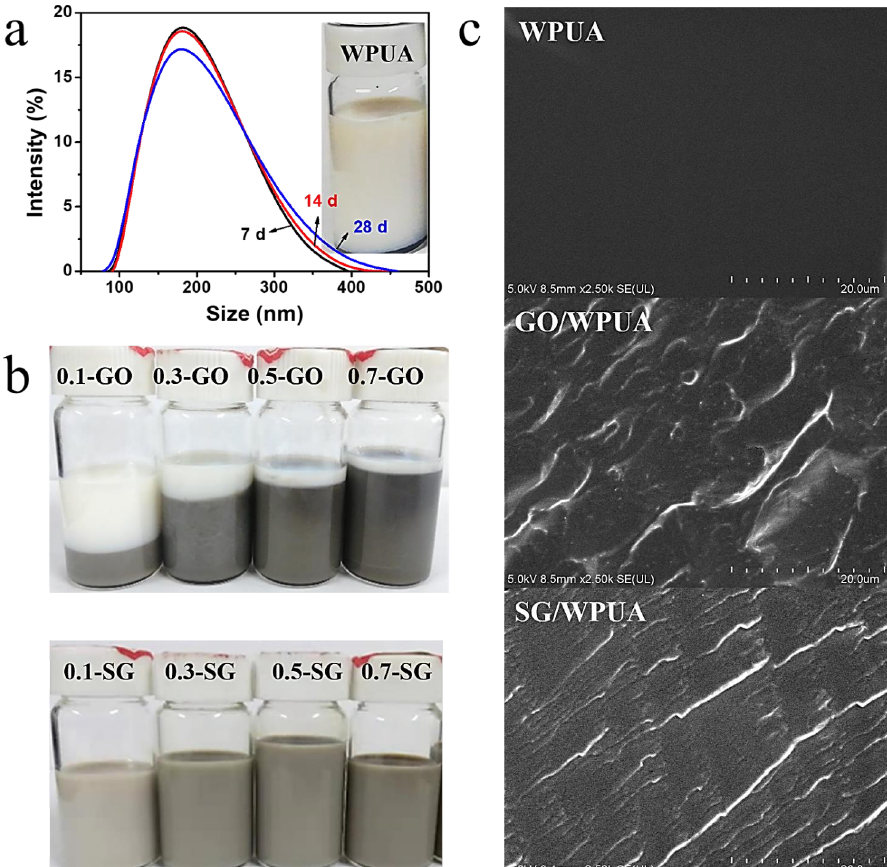
Figure 4. The particle size distribution of WPUA emulsion after standing for 7, 14, and 28 days ( a ); GO/WPUA and SG/WPUA coatings after 28 days of standing ( b ); SEM micrograph ( c ) of WPUA, GO/WPUA, and SG/WPUA with 0.3 wt.% content of filler.